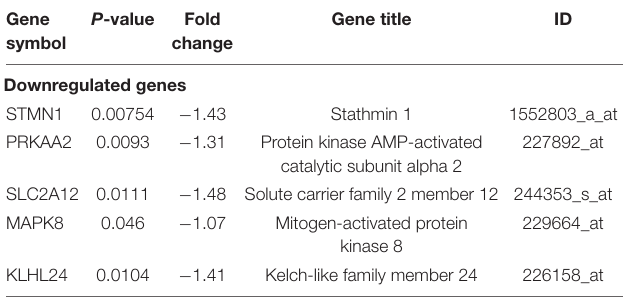
TABLE 2 | Ferroptosis differentially expressed genes of intracerebral